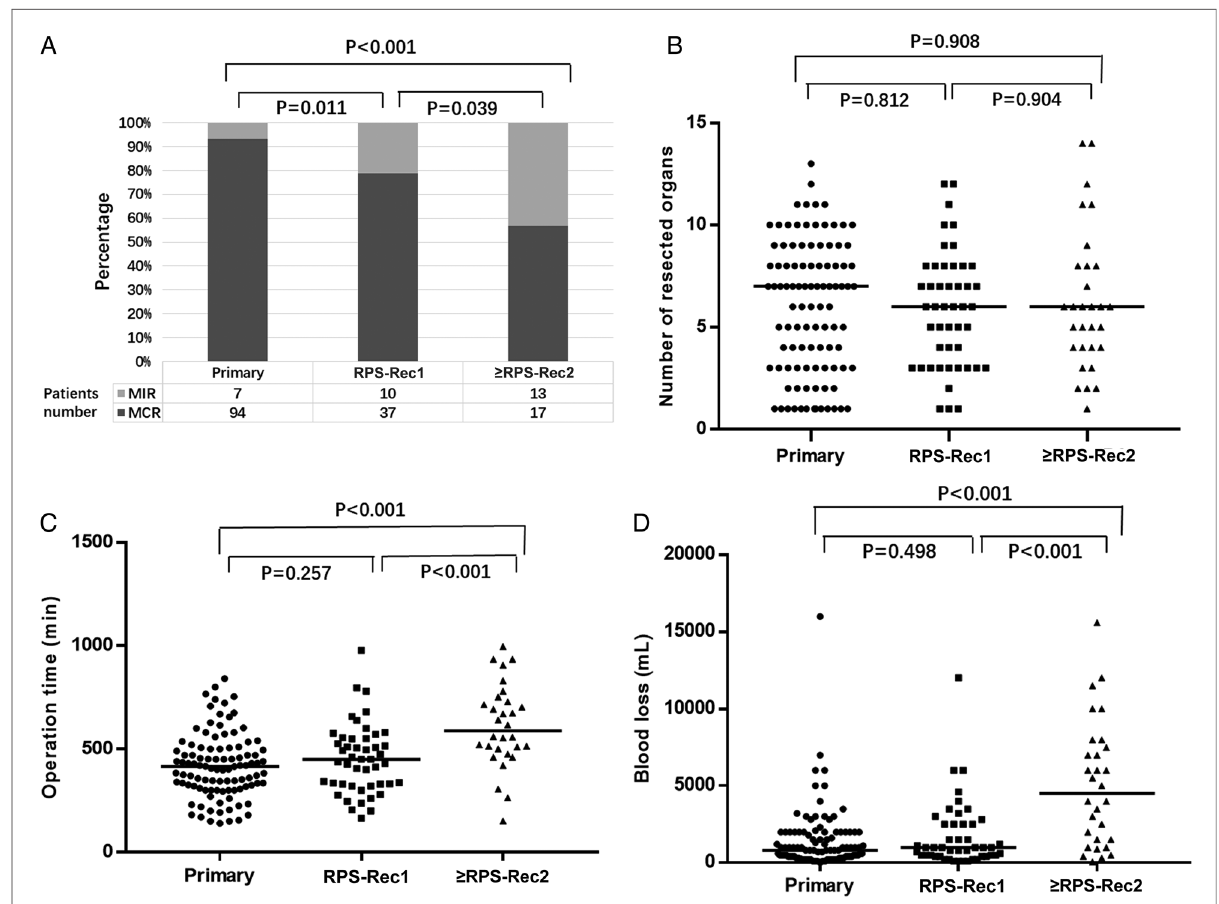
FIGURE 1 Overview of the operation. ( A ) Percentage of patients achieved MCR (primary vs. RPS-Rec1, P =0.011; primary vs. ≥ RPS-Rec2, P <0.001). ( B ) Number of resected organs (primary vs. RPS-Rec1, P =0.812; primary vs. ≥ RPS-Rec2, P =0.908). ( C ) Operation time (primary vs. RPS-Rec1, P =0.257; primary vs. ≥ RPS-Rec2, P <0.001). ( D ) Blood loss (primary vs. RPS-Rec1, P =0.498; primary vs. ≥ RPS-Rec2, P <0.001). Black lines indicate median values. MCR, macroscopically complete resection; MIR, macroscopically incomplete